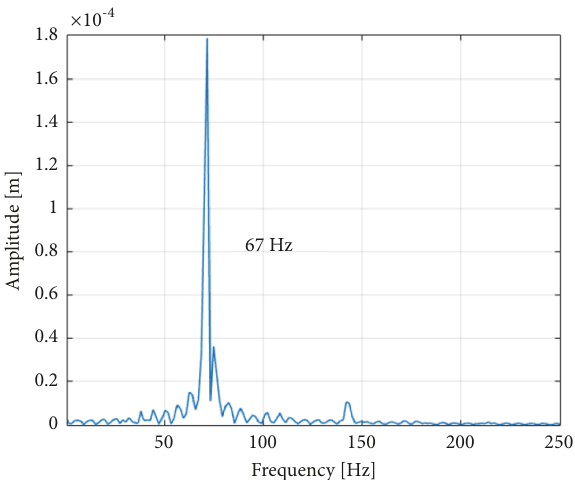
Figure 38: Simulated whirling frequency (rotor angular speed 7000 RPM).